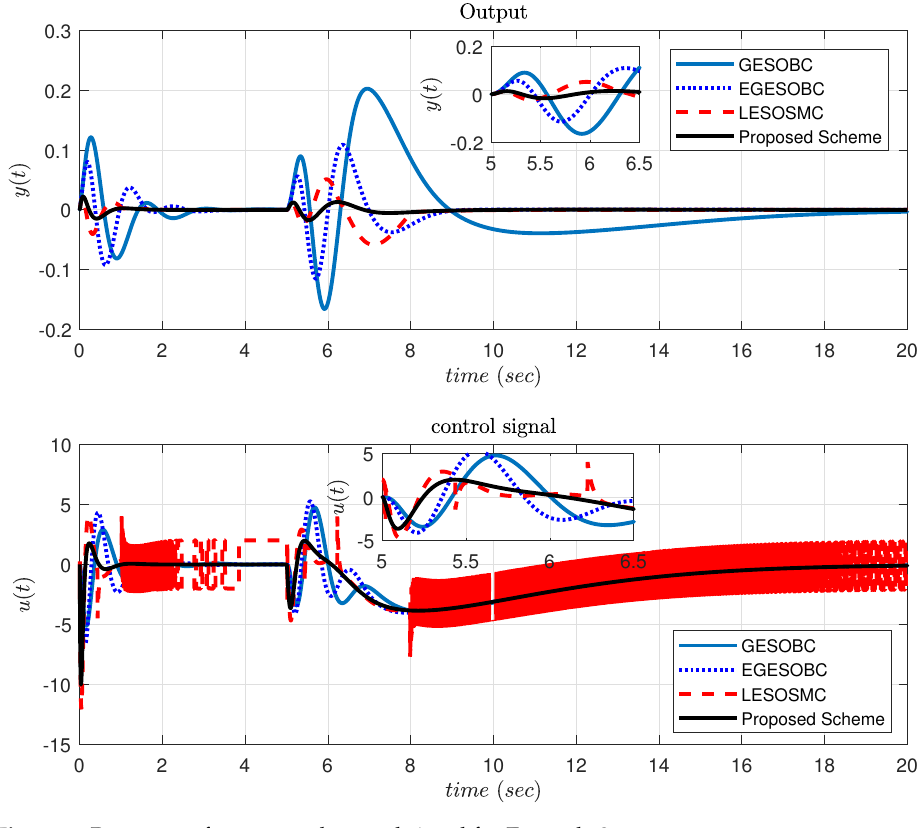
Figure 5. Response of output and control signal for Example 2.